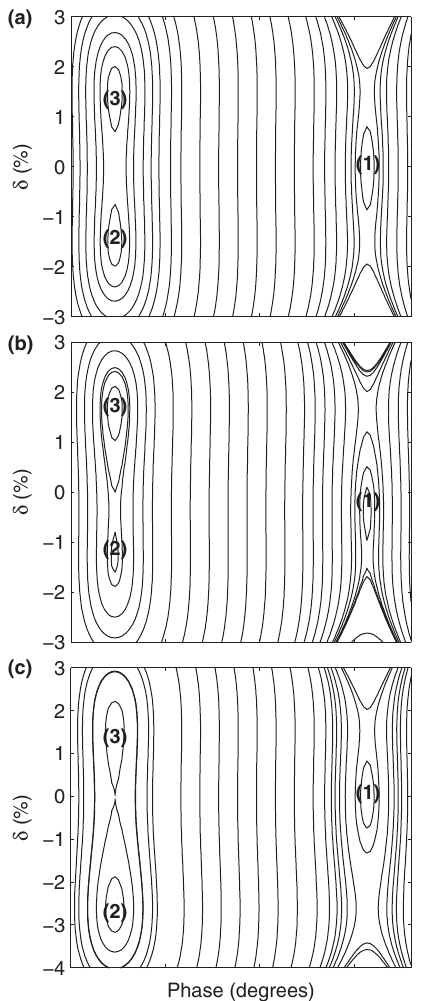
FIG. 7. Longitudinal phase spaces compatible with the three- beam event depicted in Figs. 1(a)–1(c). The two off-momentum beams (2) and (3) and the on-momentum beam (1) are derived from the modified low- (cid:1) lattice of the SOLEIL storage ring using the parameters (cid:1) 1 ¼ 2 : 2 (cid:1) 10 (cid:2) 5 and ð (cid:6); (cid:1) 2 ; (cid:1) 3 Þ : ( 4 : 3 (cid:1) 10 (cid:2) 9 , (cid:2) 1 : 9 (cid:1) 10 (cid:2) 5 , (cid:2) 9 : 3 (cid:1) 10 (cid:2) 2 ), ( 7 : 5 (cid:1) 10 (cid:2) 8 , (cid:2) 1 : 9 (cid:1) 10 (cid:2) 5 , (cid:2) 9 : 3 (cid:1) 10 (cid:2) 2 ), ( 4 : 3 (cid:1) 10 (cid:2) 9 , (cid:2) 6 : 0 (cid:1) 10 (cid:2) 4 , (cid:2) 5 : 5 (cid:1) 10 (cid:2) 2 ) re- spectively for the cases (a), (b), and (c). Case (b) is obtained by increasing the rf frequency by 25 Hz while case (c) by rising the strength of a SF sextupole by